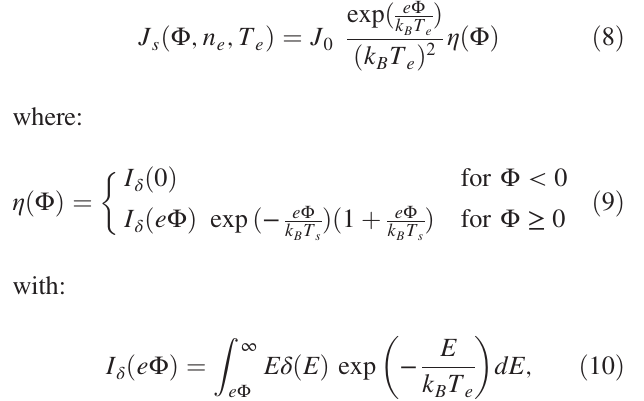
FIG. 2. Representation of a dust grain on the surface of the beam screen. The grain is bombarded by electrons from the surrounding electron cloud. Electrons with an energy of a few eV remain in the dust grain (negative charging current density J Electrons with an energy of a few 100 eV excite secondary electrons leaving the dust grain (positive charging current density J ). The grain is also bombarded by photons from the synchro- s tron radiation, leading to the positive photoelectric emission current density J h ν Fig. 2. Due to the surrounding electron cloud, the grain is constantly bombarded by electrons. Low energy electrons